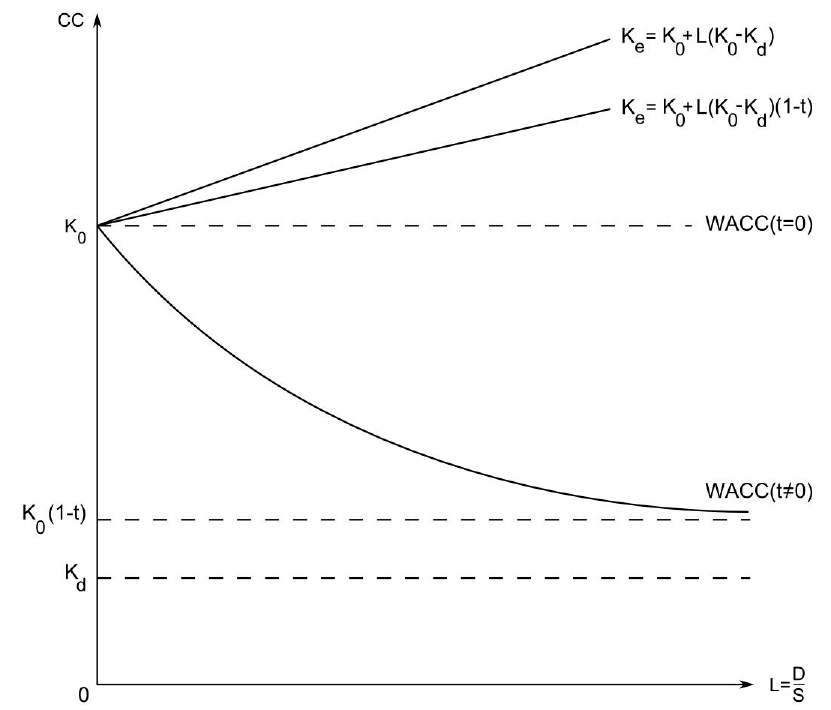
Figure 1. Dependence of equity capital cost, debt cost and WACC on leverage in Modigliani–Miller theory without taxes ( t = 0) and with taxes ( t (cid:54) = 0 ).